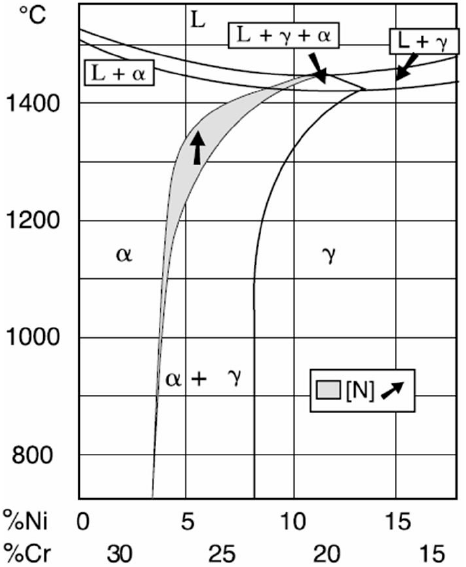
Figure 4. The phases pseudo binary Fe-Cr-Ni diagram for 68% Fe [23,24].